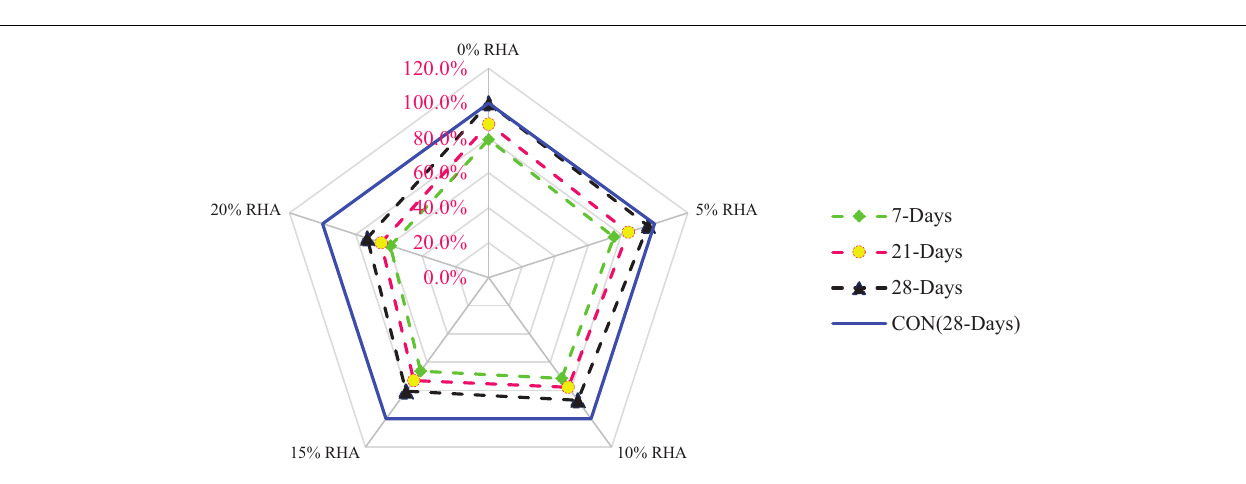
FIGURE 7 | Relative analysis split tensile strength (without steel fibers and